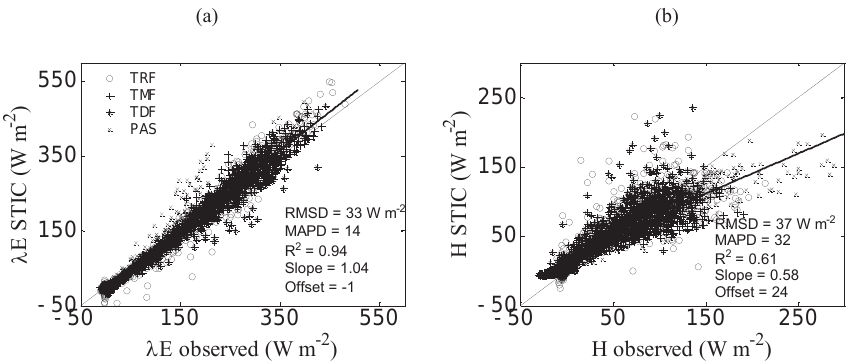
Figure 4. Comparison between STIC-derived (a) λE and (b) H over four different PFTs in the Amazon Basin (LBA tower sites). MAPD is the percent error defined as the mean absolute deviation between the predicted and observed variables divided by the mean observed variable.